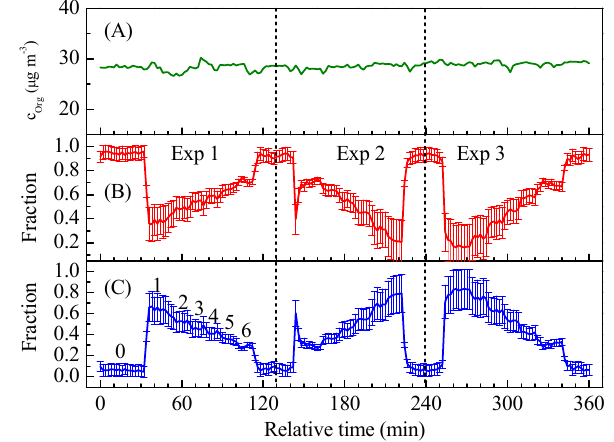
Figure 1. Changes in (a) total organic mass concentration, (b) the fraction of unreacted citric acid derived by PMF and (c) products of citric acid oxidized by OH derived by PMF, as a function of rel- ative experimental time. The values 1–6 represent a step-wise O 3 concentration decrease, corresponding to decreased OH exposure; 0 represents an O 3 concentration of zero. Experimental conditions are D m : 200nm, RH: 30 ± 3%, T :